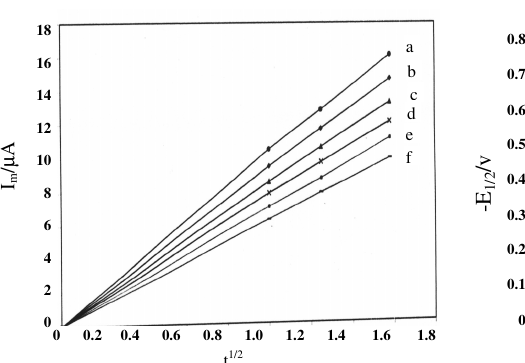
Figure 6 . I vs V 1/2 plots of fluchloralin p Con.0 0.5 mM